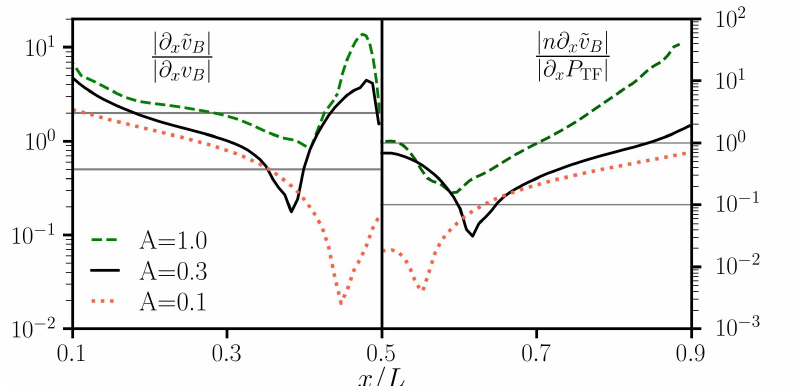
Figure 3: Left: Ratio of the forces between the exact many-fermion Bohm potential (˜ v ) and the standard Bohm potential ( v B perturbation amplitudes A . Right: Ratio of the forces due to the many-fermion Bohm potential , ˜ v , and the TF B